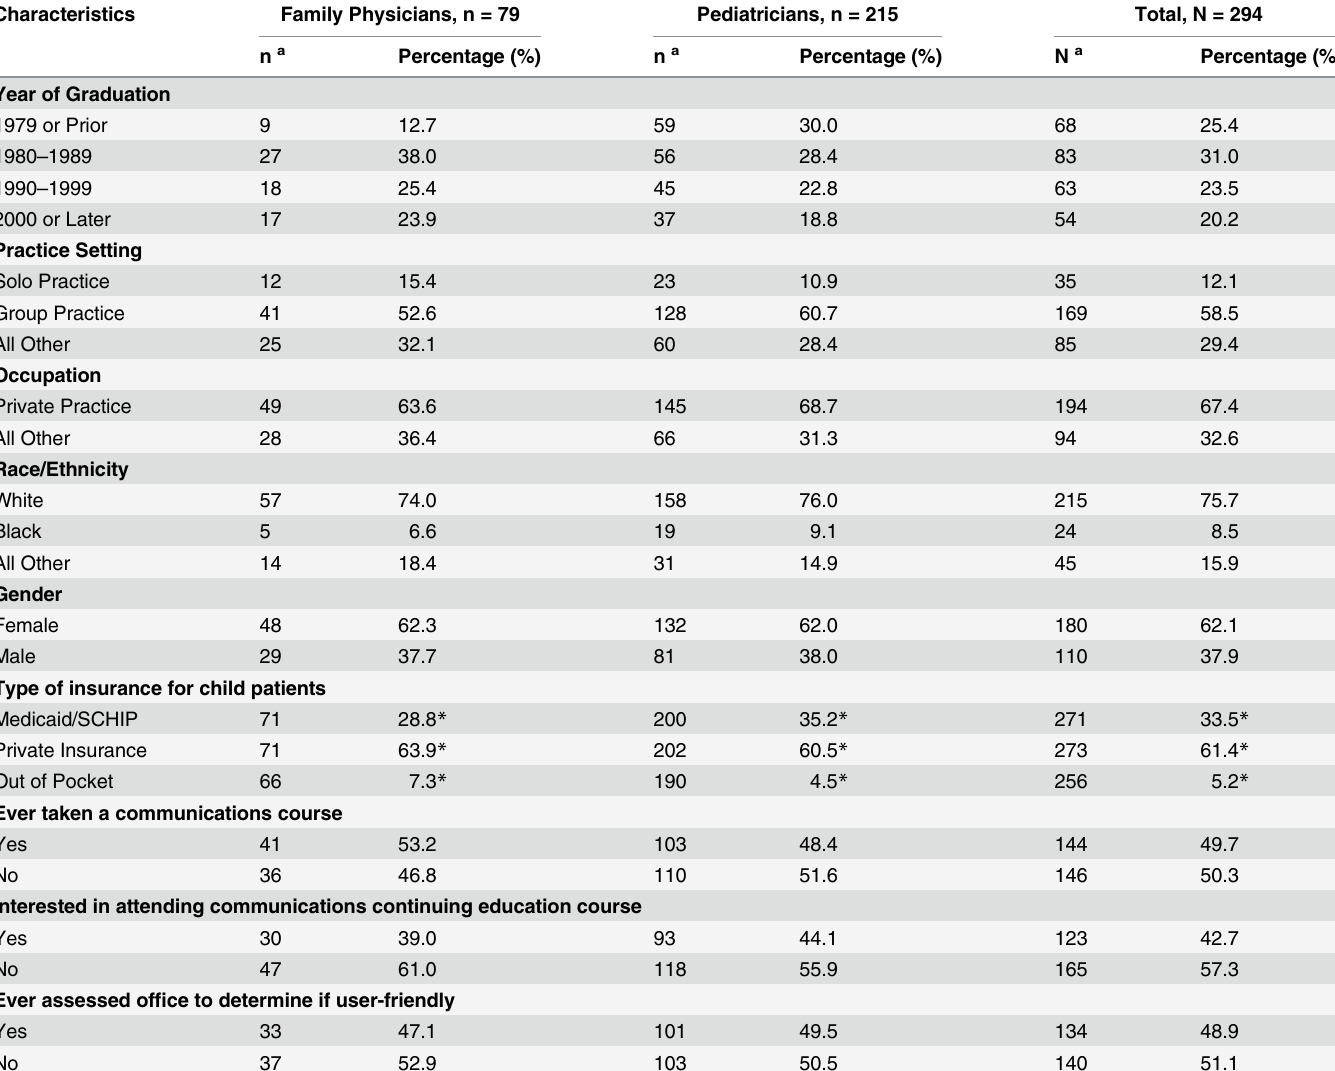
Table 1. Distribution of physicians ’ characteristics in total and by family physician and pediatrician